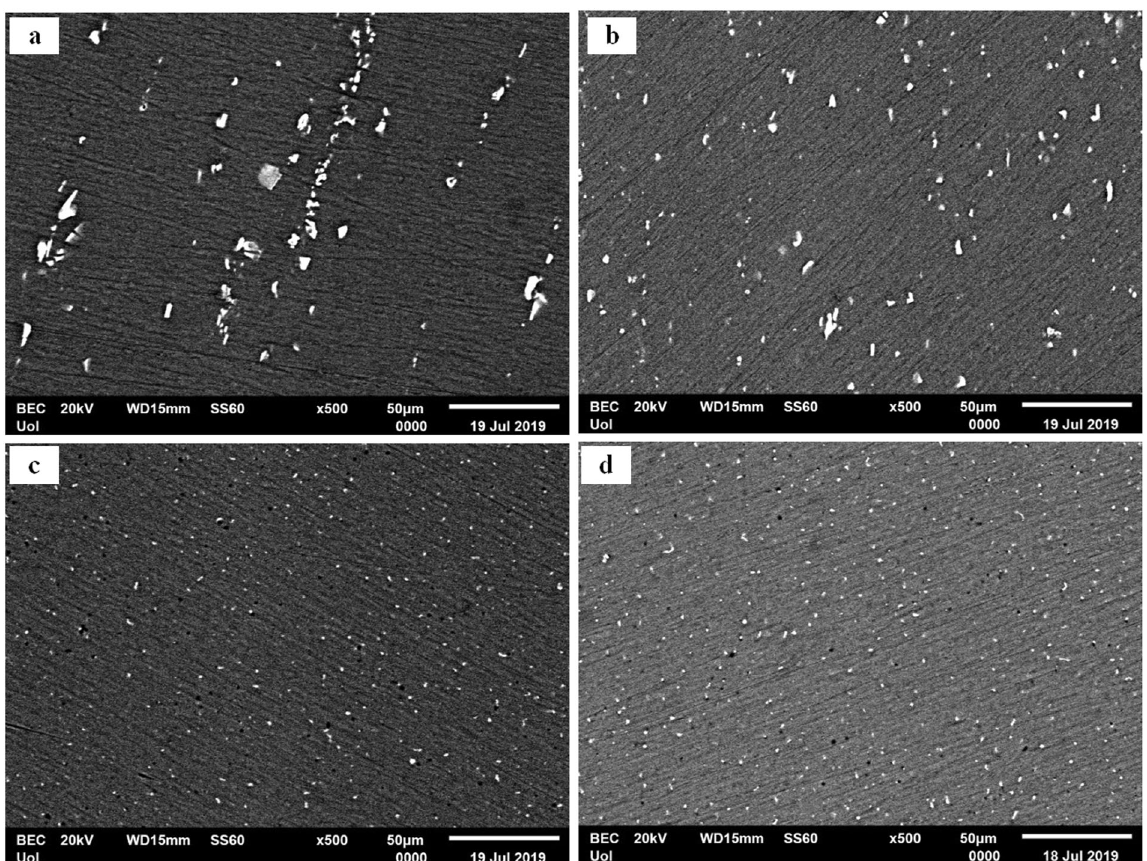
Fig. 2 SEM micrographs (BEC mode) of the as-received structure (x-y plane). a zone a: substrate; b zone b: substrate/deposited alloy interface; c zone c: interlayer boundaries; d zone d: within a deposition layer.